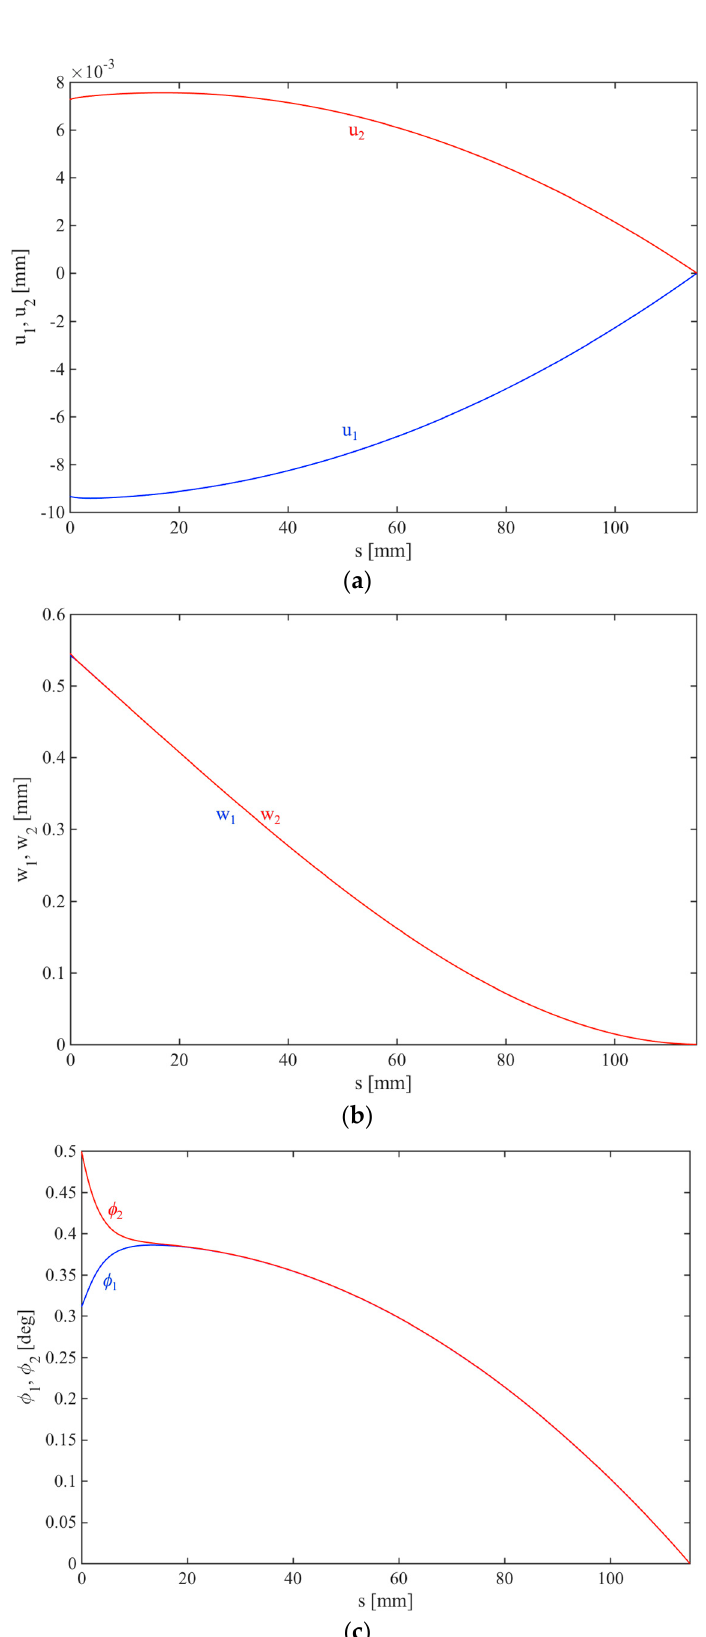
Figure 24. Composite specimen: ( a ) Axial displacement; ( b ) Shear displacement; ( c ) Cross-sectional rotation.